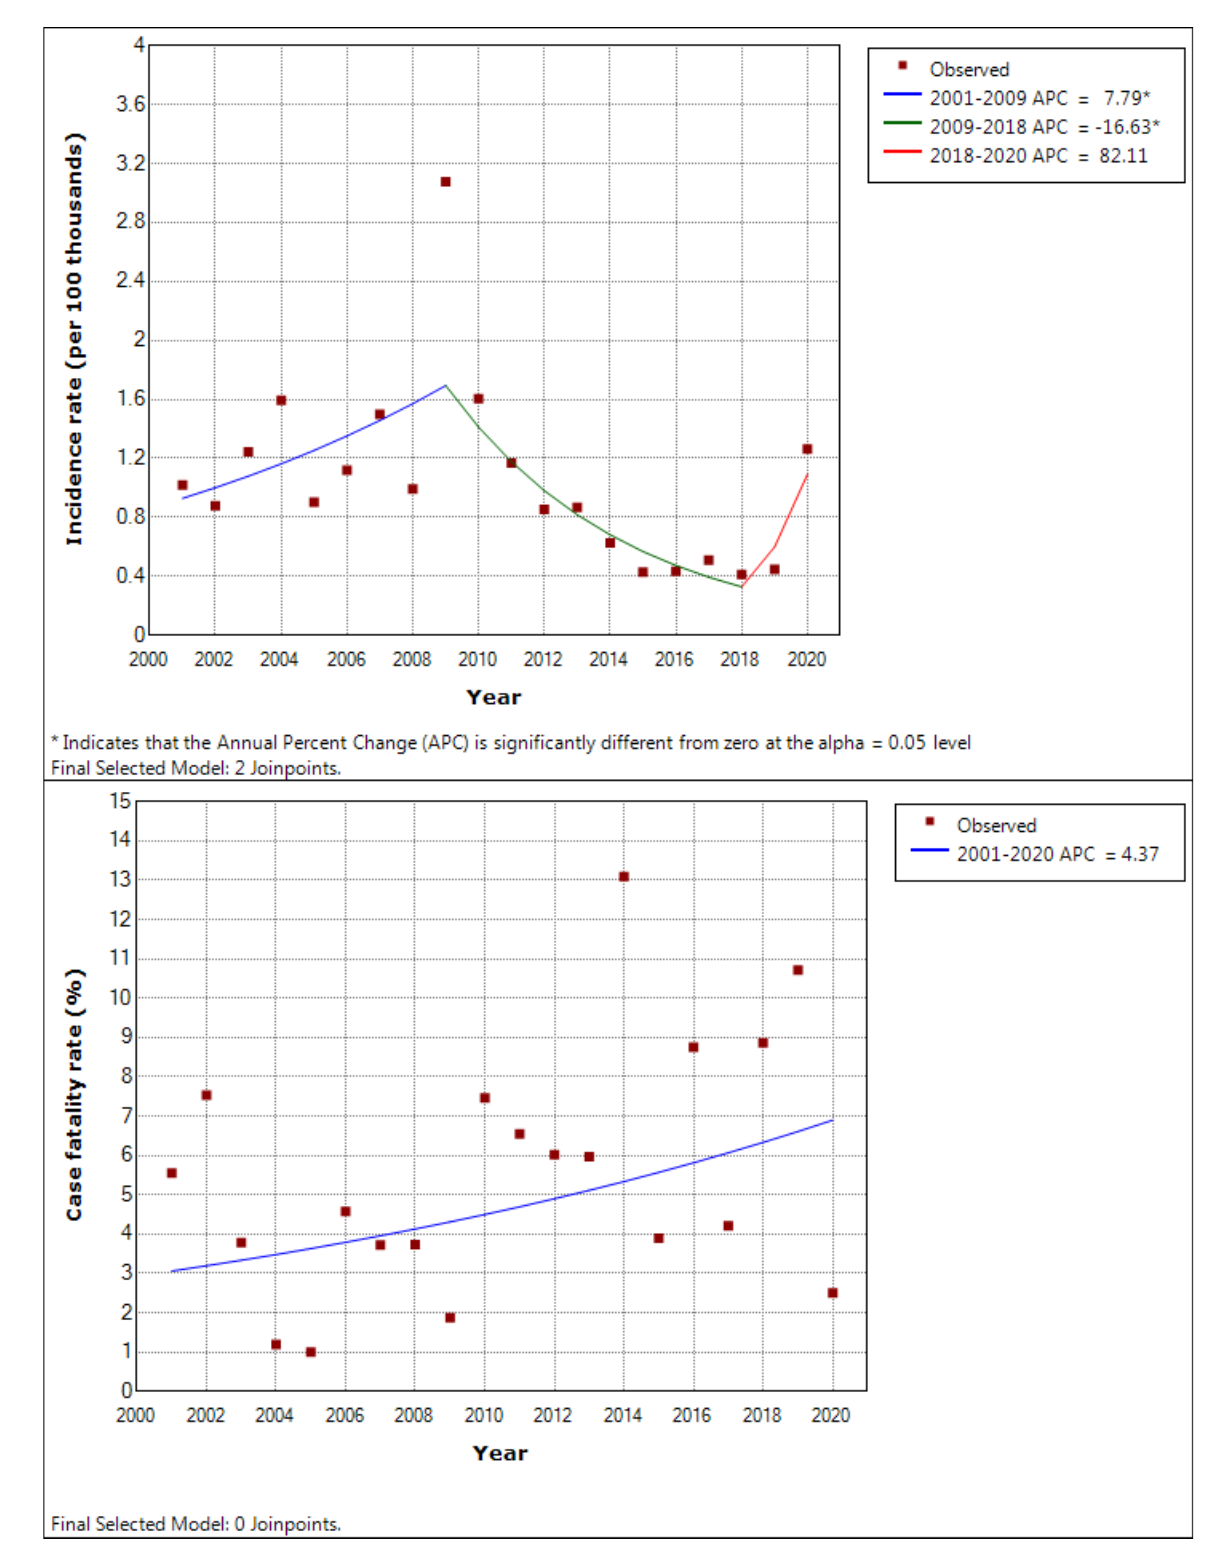
Figure 3. The incidence and fatality rate trends of occupational infectious diseases analysed by joinpoint